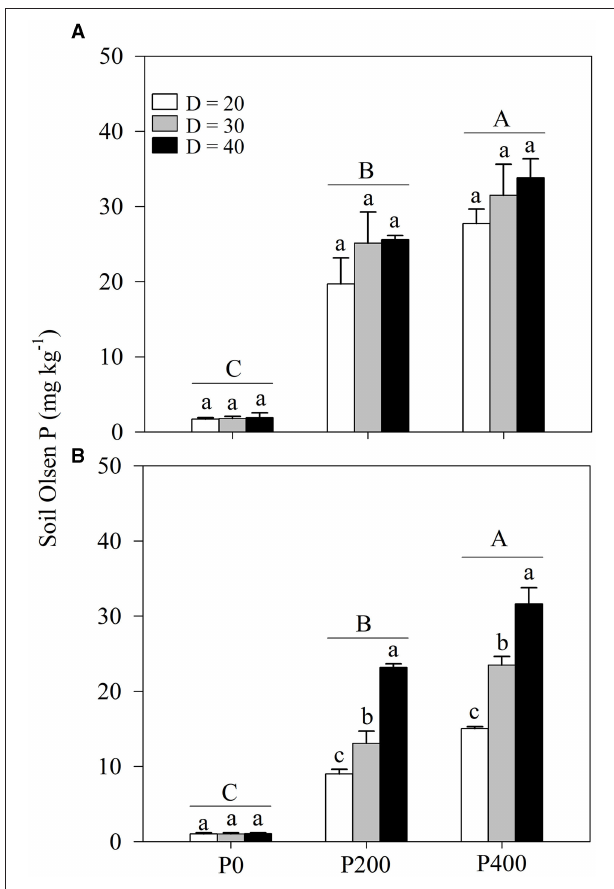
FIGURE 5 | (A) Bulk soil Olsen phosphorous (P) and (B) rhizosphere soil Olsen P under different P supply gradients and space availability conditions. Each value represents the mean of four replicates ( + SD). Different lower-case letters indicate a significant difference among different space availability levels, and different capital letters indicate a significant among different P levels ( P < 0.05). P0, 0mg P kg − 1 soil; P200, 200mg P kg − 1 soil; and P400, 400mg P kg − 1 soil; D = 20, D = 30, and D = 40 represent diameter of pot is 20, 30, and 40cm,